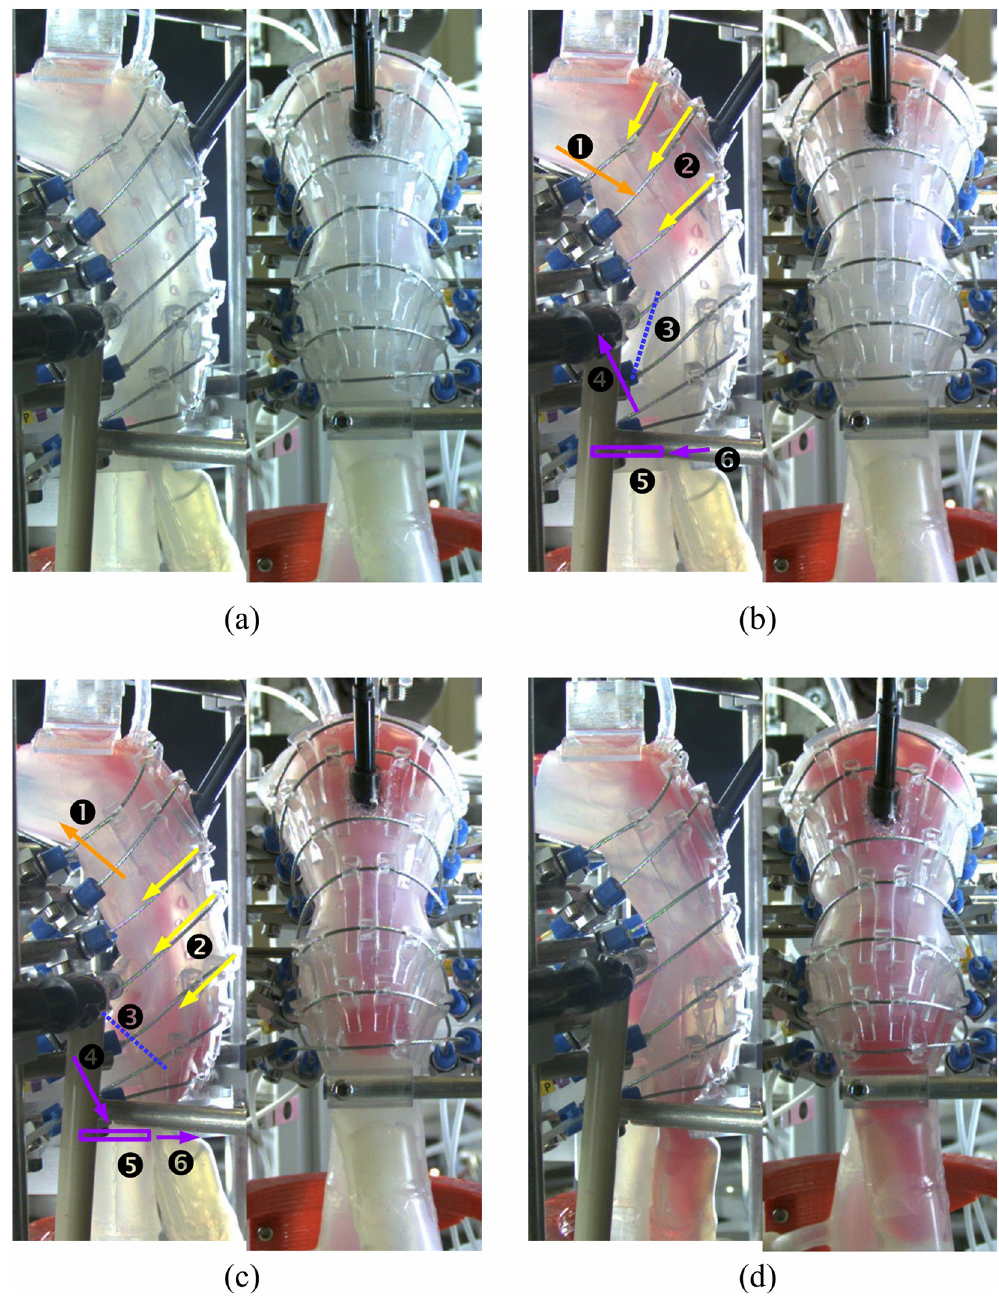
Fig 9. Video captures recorded by lateral and rear high-speed cameras of a normal pharyngeal swallowing sequence of 10 ml tick bolus reproduced by Swall-E robot. (a) [0 ms] Bolus injection in the oropharyngeal cavity. (b) [250 ms] Tongue base push (1); upper pharyngeal contraction (2); initiation of epiglottic tilt (3); initiation of laryngeal elevation (4); adduction (closure) of vocal folds (5) and UES opening (6). (c) [500 ms] Initiation of tongue base retraction (1); middle pharyngeal contraction (2); epiglottis fully tilted (3); initiation of laryngeal descent (4); vocal folds adducted/closed (5) and UES closing (6). (d) [1000 ms] Bolus entering the esophagus; resetting of actuators.